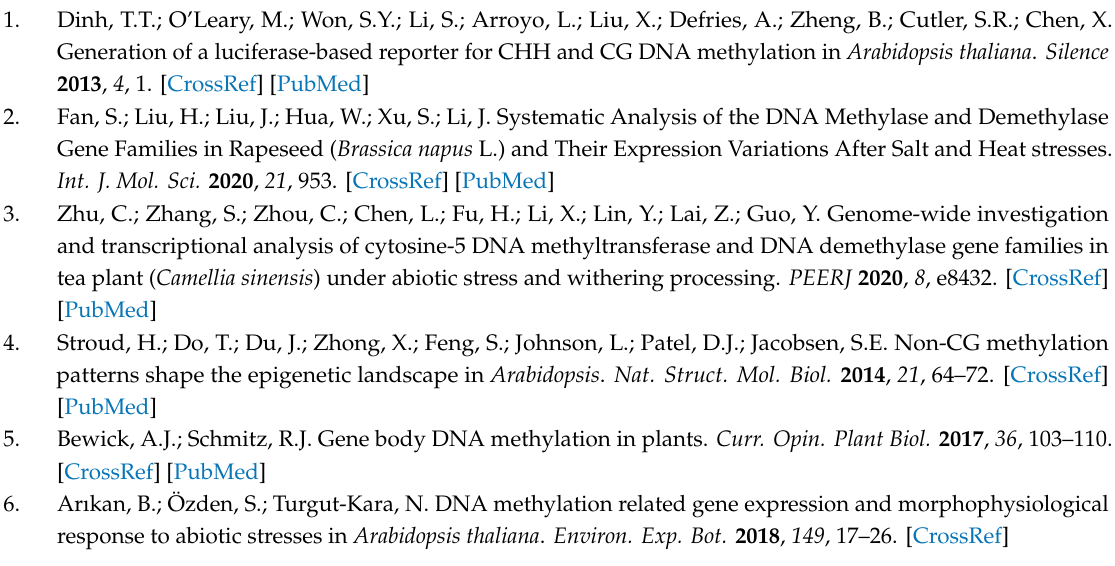
Figure S1: Motif and gene structure of DNA methylation genes in Ginkgo biloba ; Figure S2: Visualization of the eigengene network representing the relationships among the modules and the DNA methylation pathway genes; Figure S3: Gene Ontology (GO) enrichment of genes from six correlated WGCNA modules. p values Table S2: Gene ID of MET, CMT, AGO, RDR and DCL gene families used for the phylogenetic analysis; Table S3: RNA-seq data of di ff erent tissue samples collected from this study and SRA database; Table S4: RNA-seq data of 126 samples downloaded from NCBI SRA database and used for WGCNA; Table S5: Top 30 coexpressed genes with two groups of DNA methylation pathway